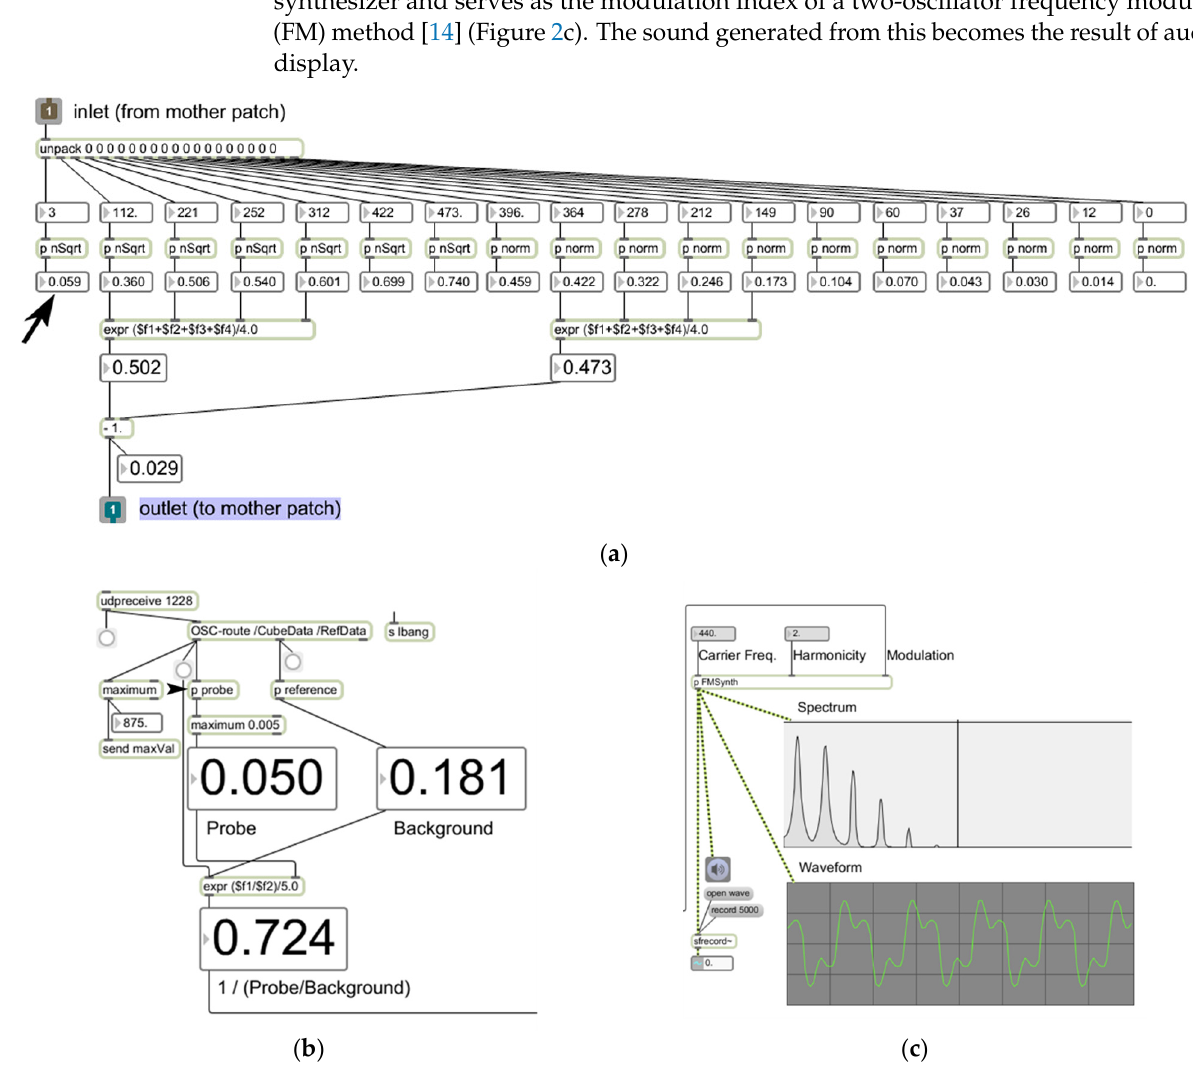
Figure 2. Components of the preprocessor and the sound synthesizer built on Max: ( a ) shows the algorithm to produce a target value; ( b ) illustrates the normalization process to provide the parameter value for sound synthesis; and ( c ) depicts the FM sound synthesis patch used for this study as well as the spectrum and waveform of the result of auditory display.